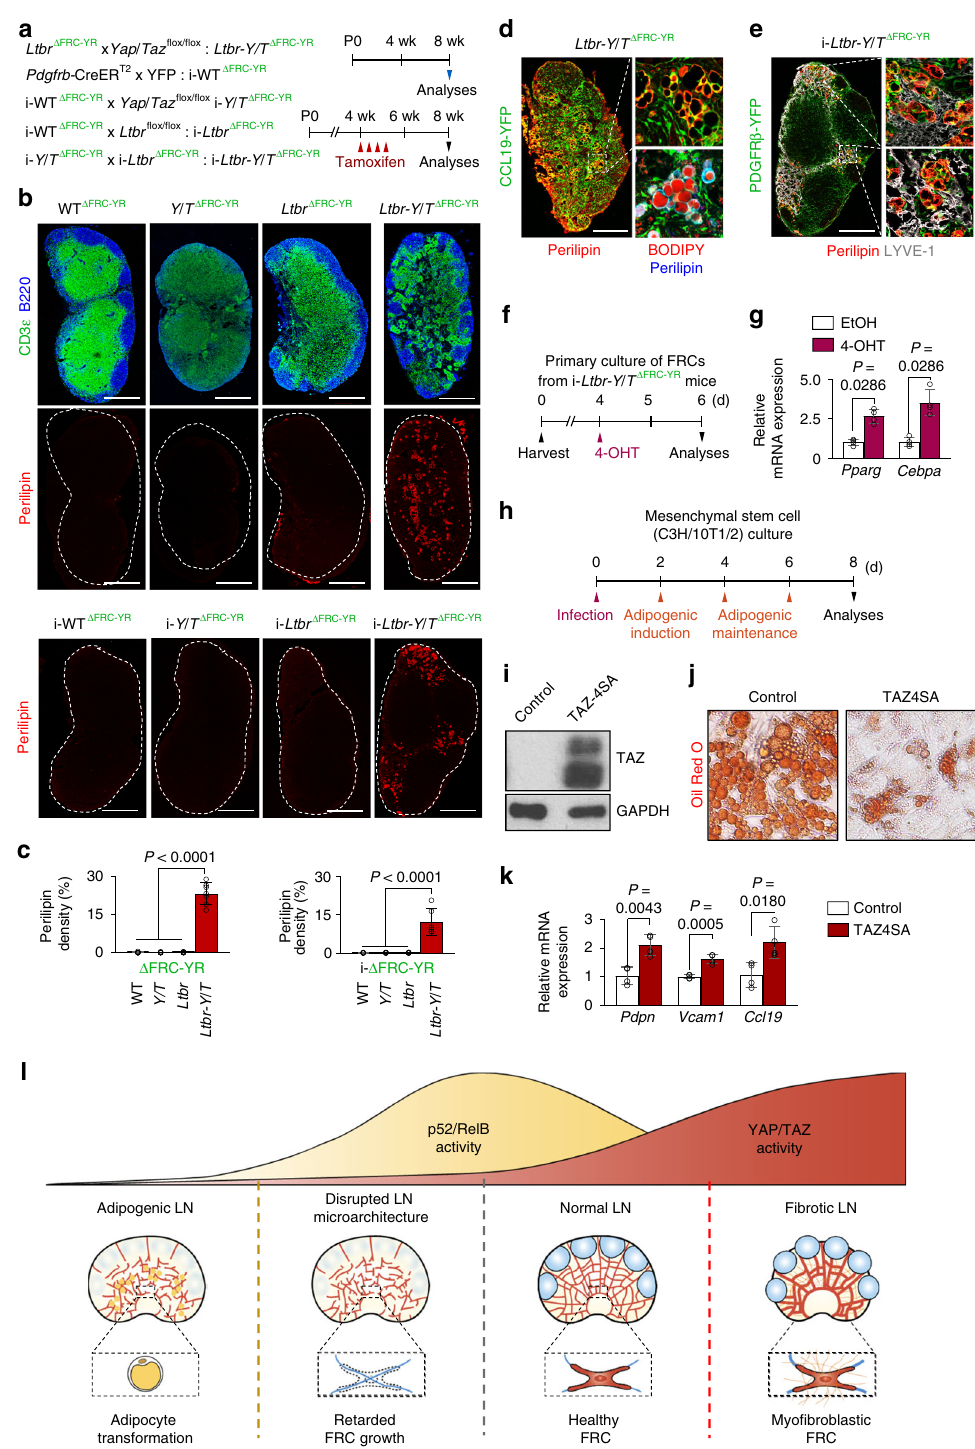
(Triton X ‐ 100 reduced to 0.1%) and boiled with Laemmli sample buffer. For detection of p52, the TrueBlot anti-Rabbit IgG HRP (ROCKLAND, Cat. 18-8816- 31) was used as secondary antibody for reducing the heavy chain